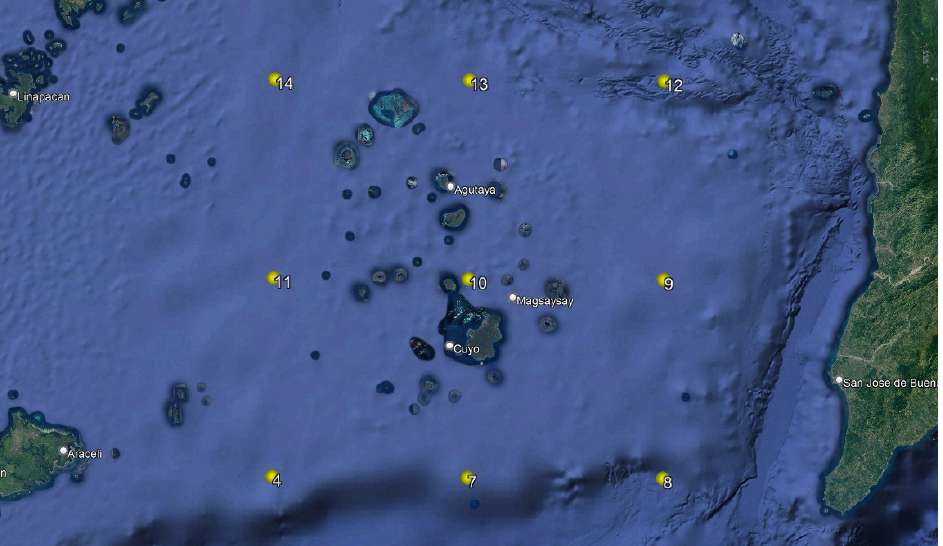
Figure 3. Cuyo Island showing the 9 stations of MOV’s 40-year hindcast wave data used to determine the average P d and H s surrounding Cuyo Archipelago (yellow dots) and used as initial conditions to SWAN (stations 4, 8, 12 and 14).